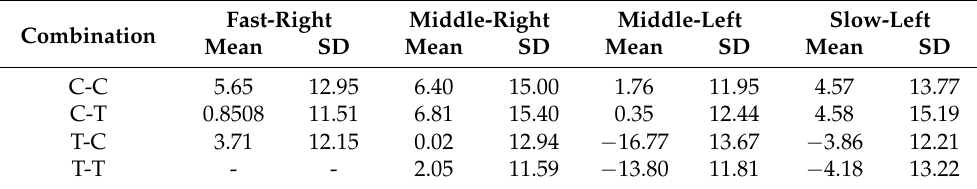
Table A3. The mean and standard deviation of ∆ V of m and